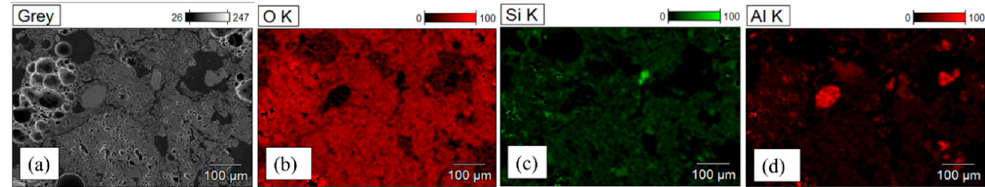
Figure 4. SEM/SE image ( a ) of the Thermacoat™ and accompanying maps presenting a distribution of O ( b ), Si ( c ) and Al ( d ) (the former being major constituents of cement).